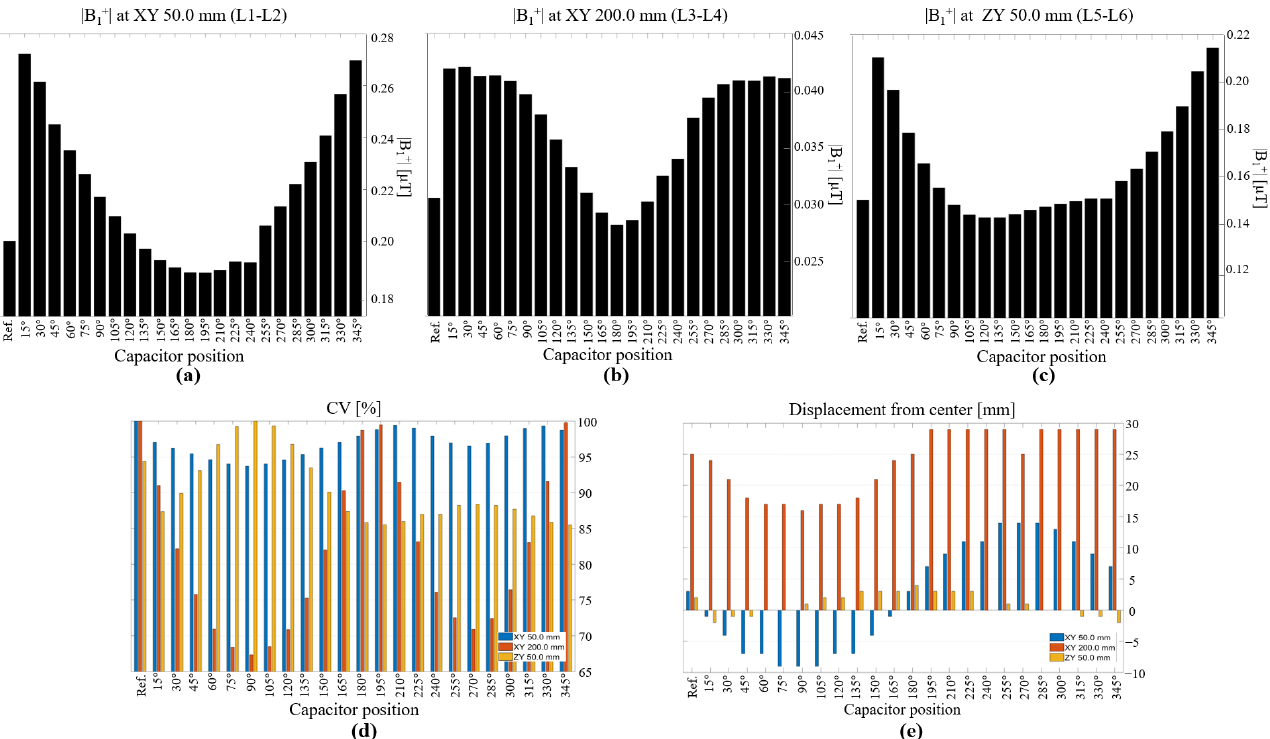
Figure 6. Statistical analysis of |B 1+ | field in empty space, showing mean values for line profiles ( a ) in XY plane, at 50 mm, ( b ) in XY plane, at 200 mm, and ( c ) in ZY plane, at 50 mm. ( d ) CVs for all tested coil configurations and line profiles; values have been scaled based on the maximum for easier comparison. ( e ) Focus of the field, computed based on displacement of maximum value from the center, for all line profiles.